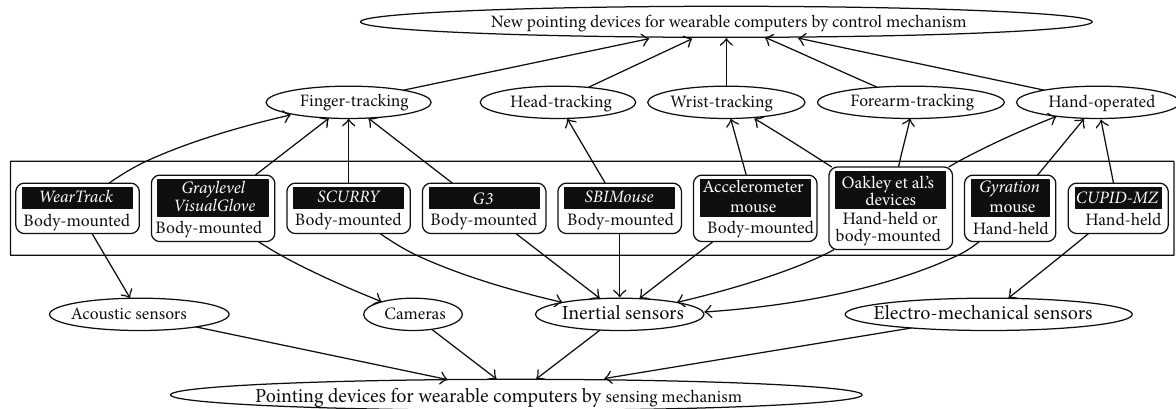
Figure 2: Directed graph depicting the conceptual design landscape for new wearable pointing devices from control (top) and sensing (bottom) mechanism perspectives. The form factor of each device is given in the bottom half of each rectangular node